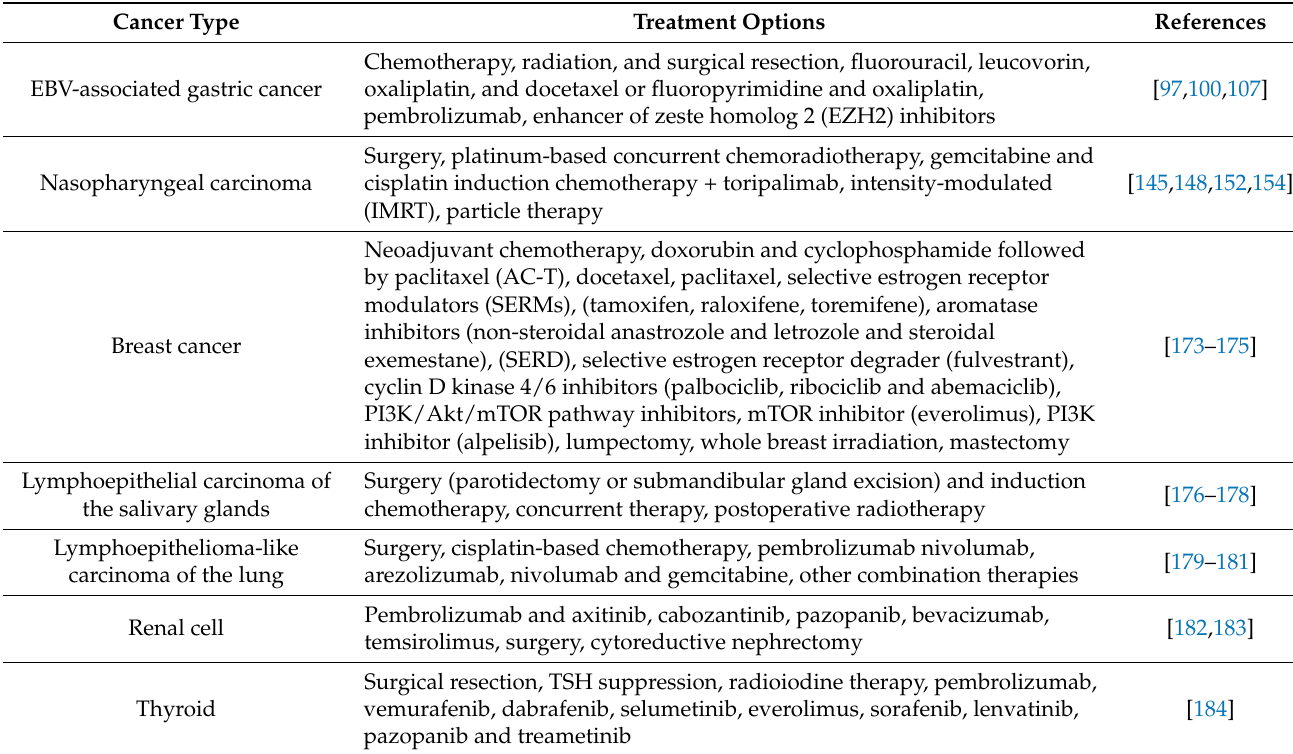
Table 3. Cancers associated with EBV and their